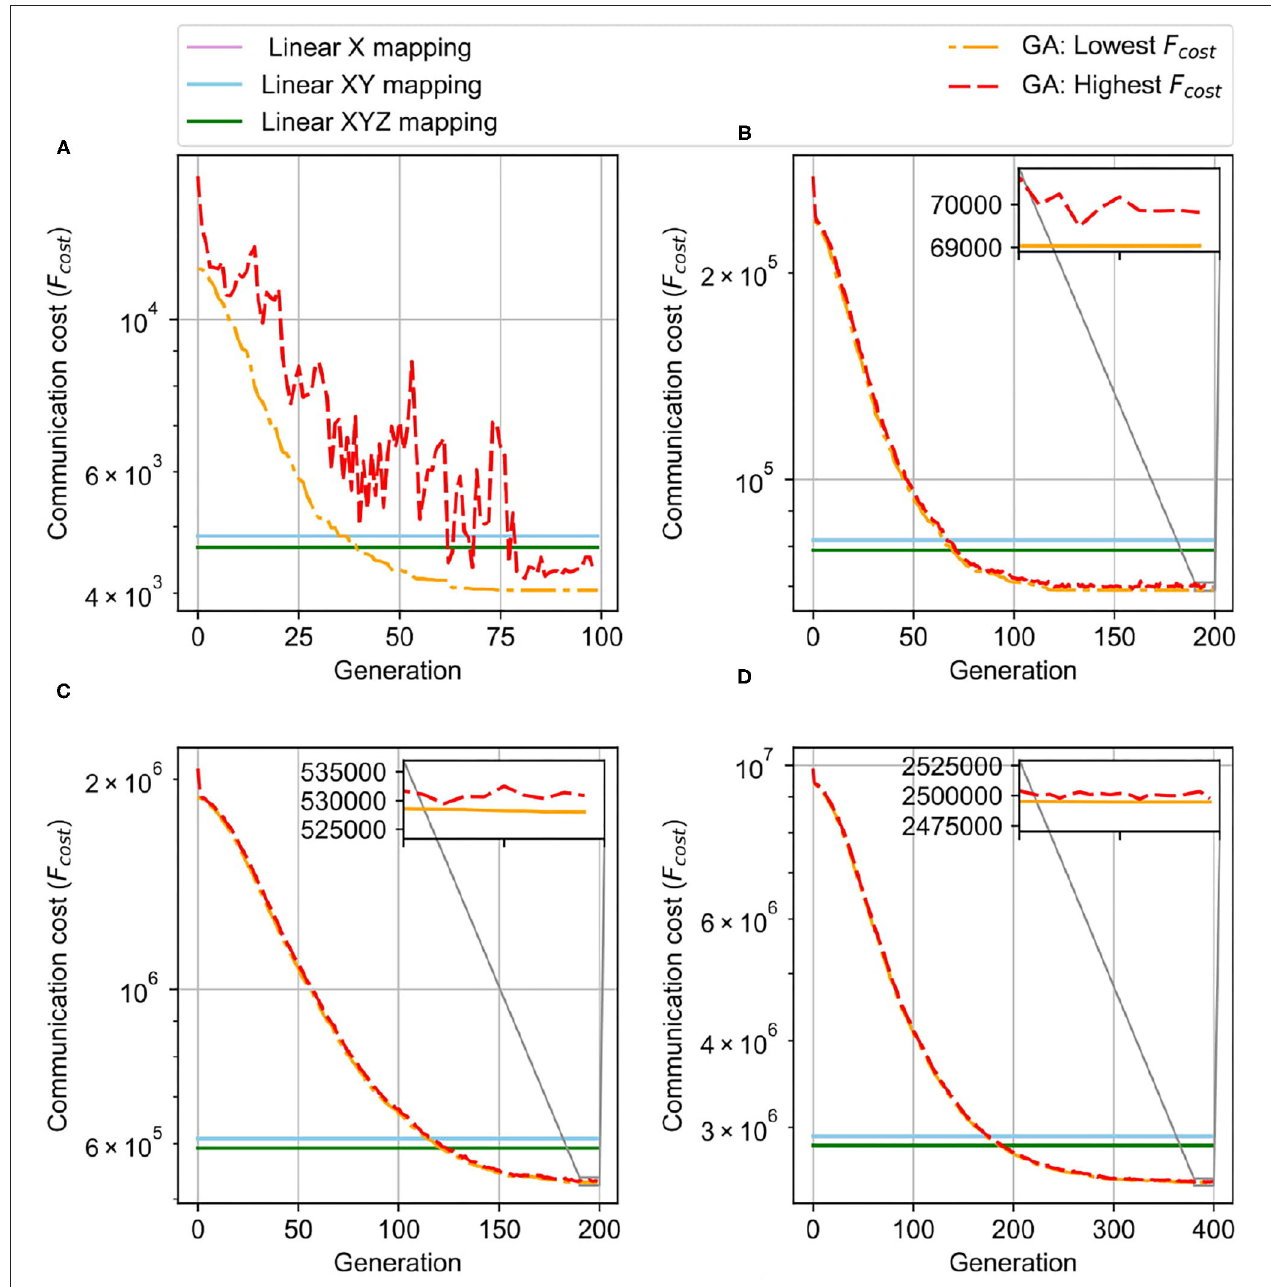
FIGURE 12 | Genetic Algorithm Result for initial mapping. (A) 4 × 4 × 4 NoC-based, 256 neurons/node. (B) 6 × 6 × 6 NoC-based, 256 neurons/node. (C) 8 × 8 × 8 NoC-based, 256 neurons/node. (D) 10 × 10 × 10 NoC-based, 256